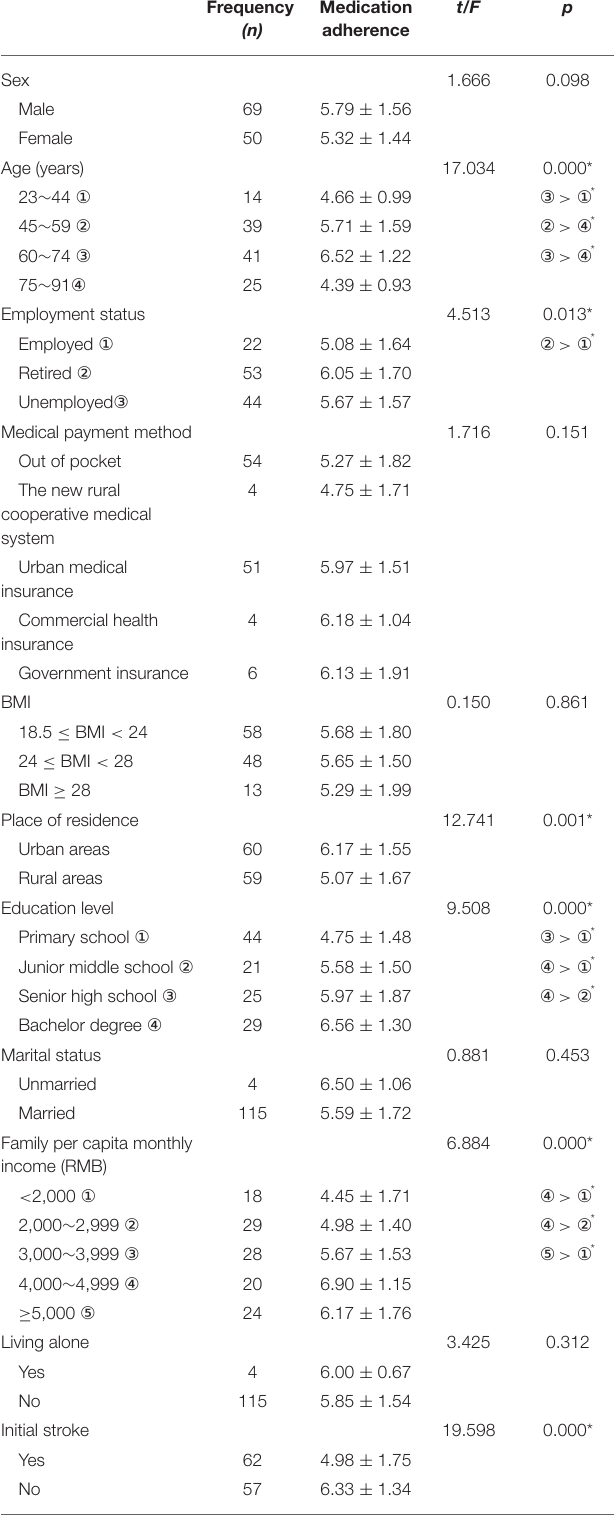
TABLE 4 | Univariate analysis of the influence of sociodemographic and clinical data on medication adherence ( n = 119, ¯ x ± s ). Frequency